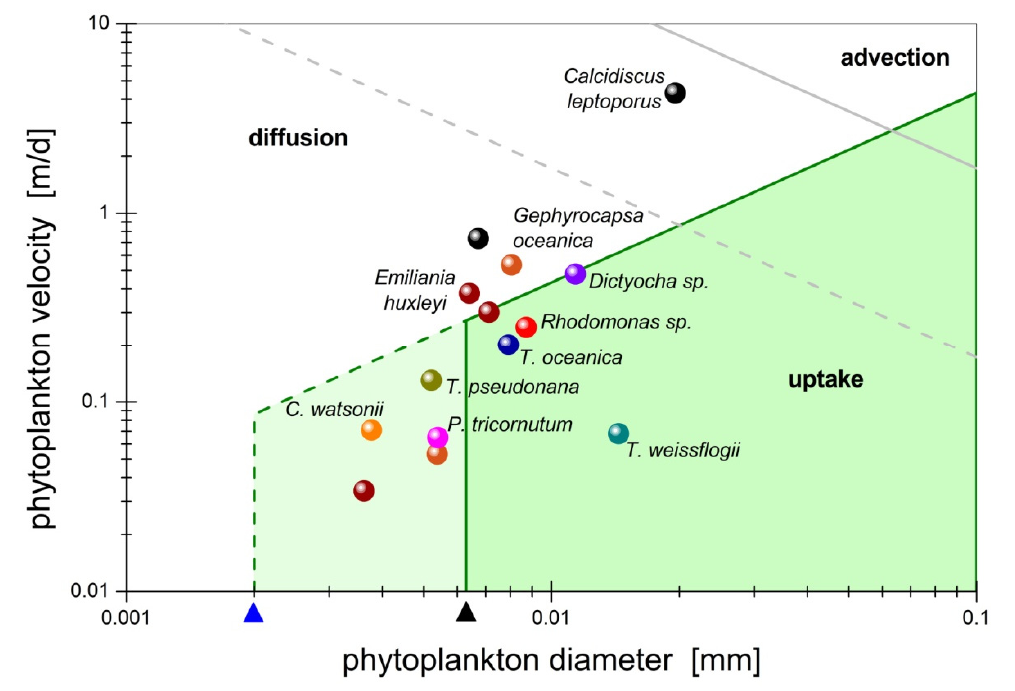
Figure 9. Phase diagram in the velocity-size space delineating the domain of prevalence for the fundamental transport processes that shape the nutrient field around individual phytoplankton cells. The symbols correspond to experimental data (Table 1 in [86]). The lines represent theoretical boundaries estimated by timescale conditions. The grey lines correspond to Pe = 1. The dark green lines correspond to Pe/Da = 100 with uptake timescale (cid:101) τ U = 100 s . The arrowheads point at critical diameters corresponding to Da = 10 − 4 . The nutrient diffusivity is (cid:101) D A υ = 10 − 5 cm 2 / s for small solutes (black arrow, solid lines) and (cid:101) D A υ = 10 − 6 cm 2 / s for large solutes (blue arrow, dashed